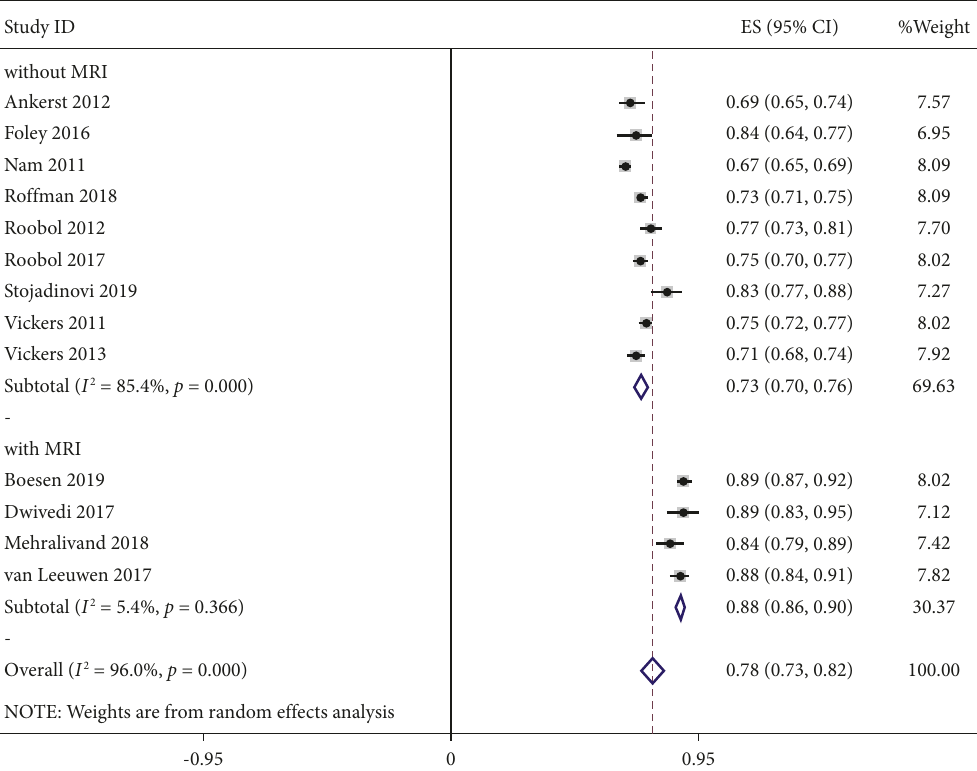
Figure 3: Forest plot of AUC (95% CI) of predictive models according to with/without